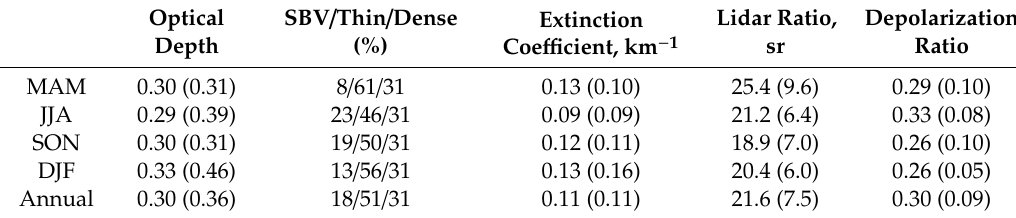
Table 2. Mean values and standard deviations (in parentheses) of cirrus optical properties from seasonal and annual statistics.